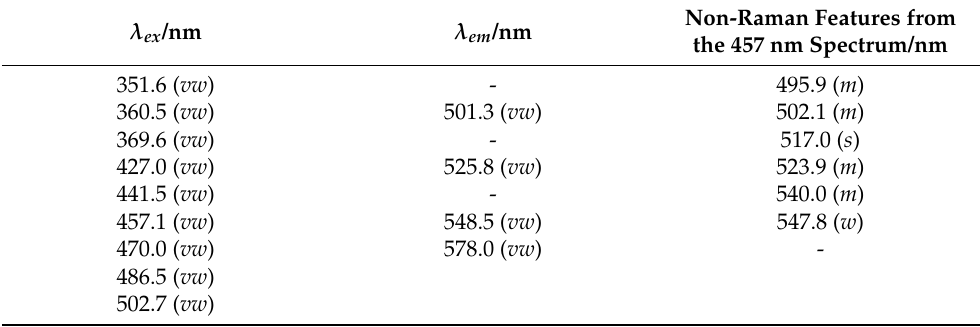
Table 1. Summary of the resolved peak positions for johannite (NMW 67.154GR.9) from the lumines- cence emission ( λ em ) and excitation ( λ ex ) spectra (Figure 5) and non-Raman features in the 457 nm Raman spectrum (Figure 7). Intensity described as strong ( s ), medium ( m ), weak ( w ), and very weak ( vw ). The error in the peak position was taken as twice the bandwidth setting ( ± 3.0 nm) for the luminescence data and the variation between Raman measurements ( ± 0.2 nm). Non-Raman Features from λ ex /nm λ em /nm the 457 nm Spectrum/nm 351.6 ( vw ) - 495.9 ( m